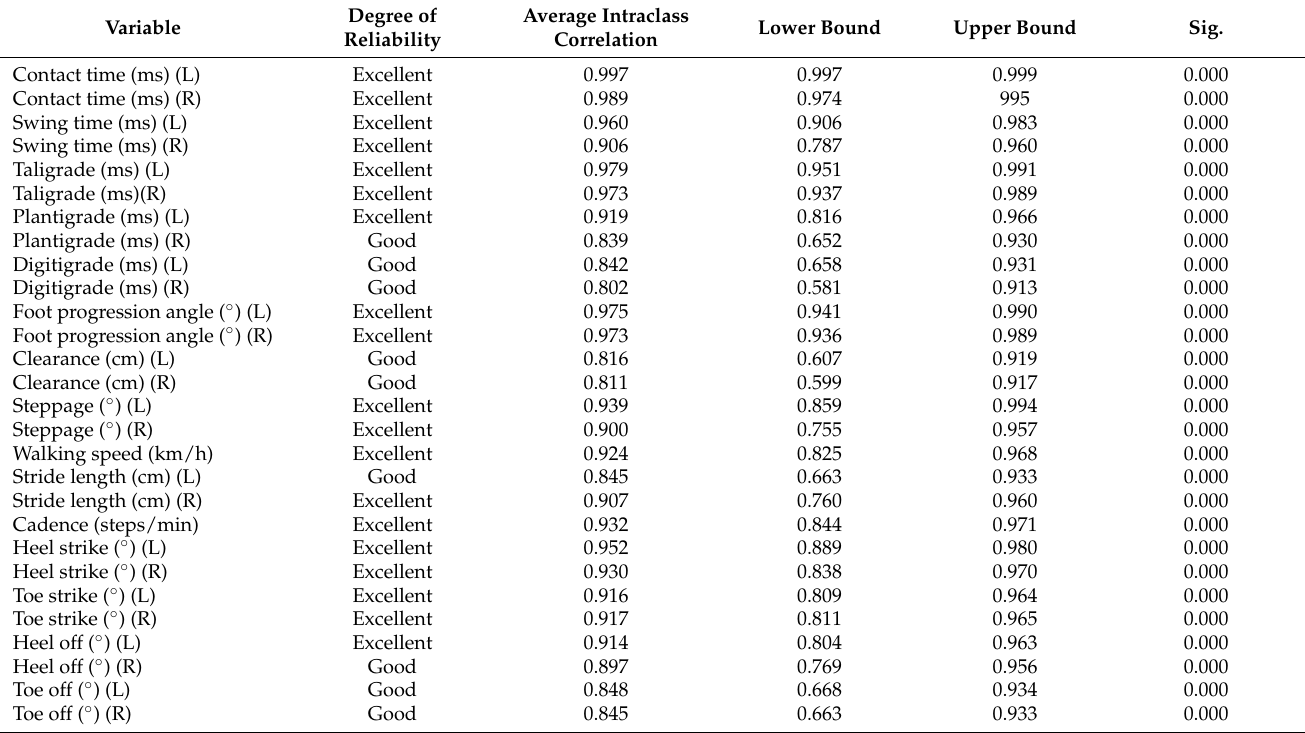
Table 3. Intraclass Correlation Coefficient values for each variable as measured using PODOSmart ® gait analysis insoles. Degree of Average Intraclass Lower Bound Upper Bound Sig. Variable Reliability Correlation Contact time (ms)